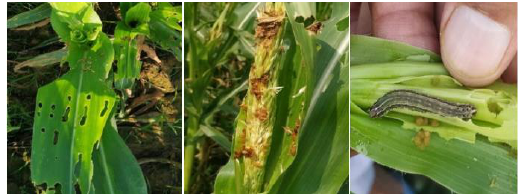
Figure 5: Windowing of leaves (left), ear feeding (middle) and moist frass (right) in the feeding area (Lamsal et al., 2020)